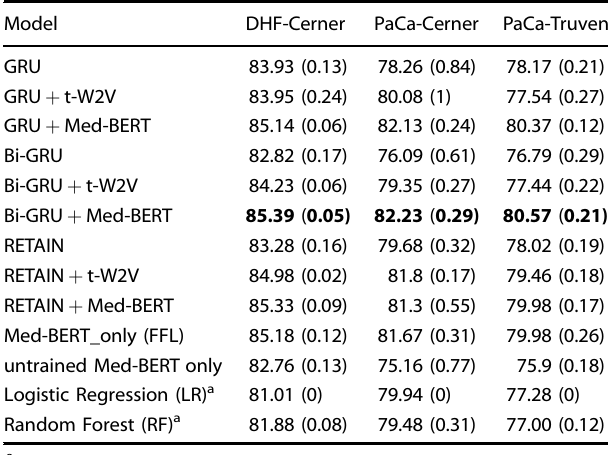
Table 4. Average AUC values and standard deviations (in parentheses) for the different methods for the three evaluation